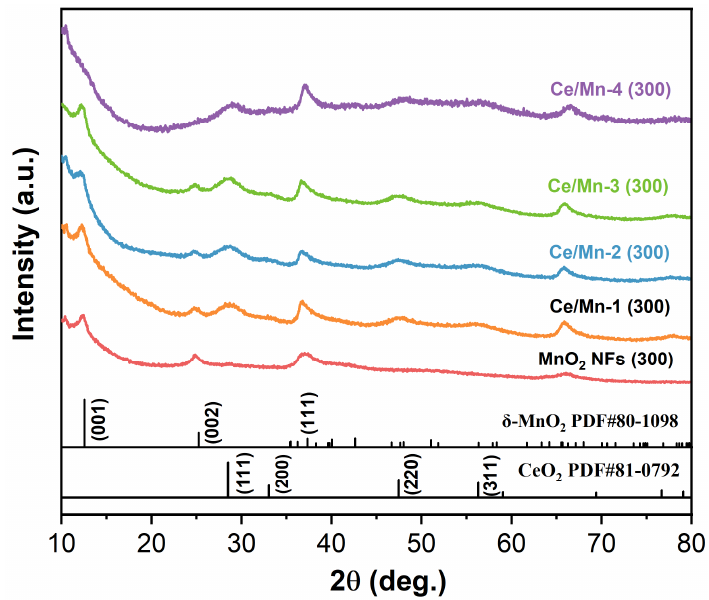
Figure 2. XRD patterns of MnO 2 NFs and CeO 2 -MnO 2 composites with different Ce/Mn ratios calcinated at 300 ◦ C.